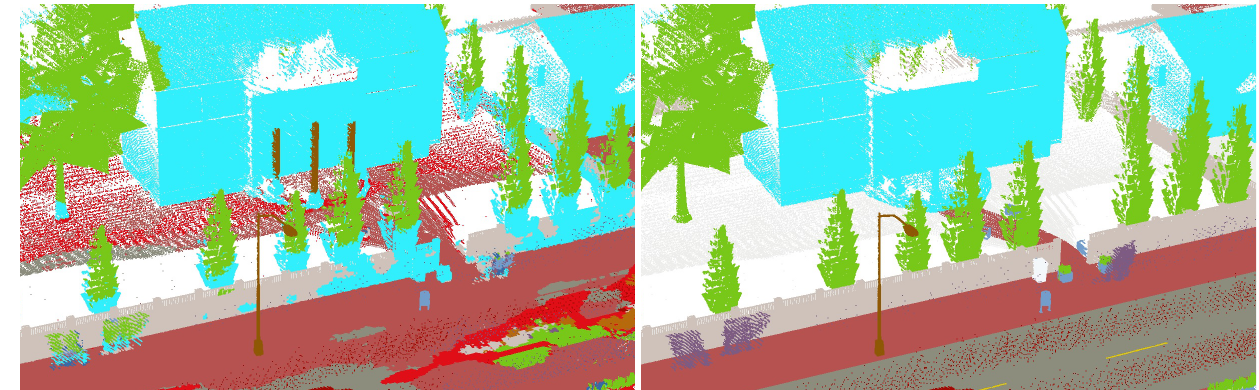
Figure 5. Left , prediction in T 1 test set of CARLA data using KPConv model. Right , ground truth.